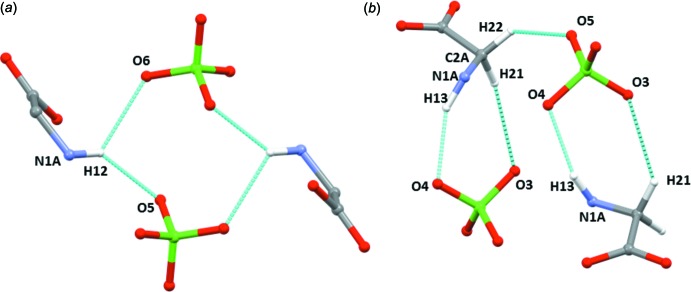
(a) The glycinium mol­ecules and perchlorate anions form a closed (8) loop through inter­molecular N—H⋯O hydrogen bonds. (b) The glycinium mol­ecules and perchlorate anions are inter­connected by N—H⋯O and Cα—H⋯O inter­actions, forming a ring motif, with adjacent rings connected by Cα—H⋯O inter­actions.